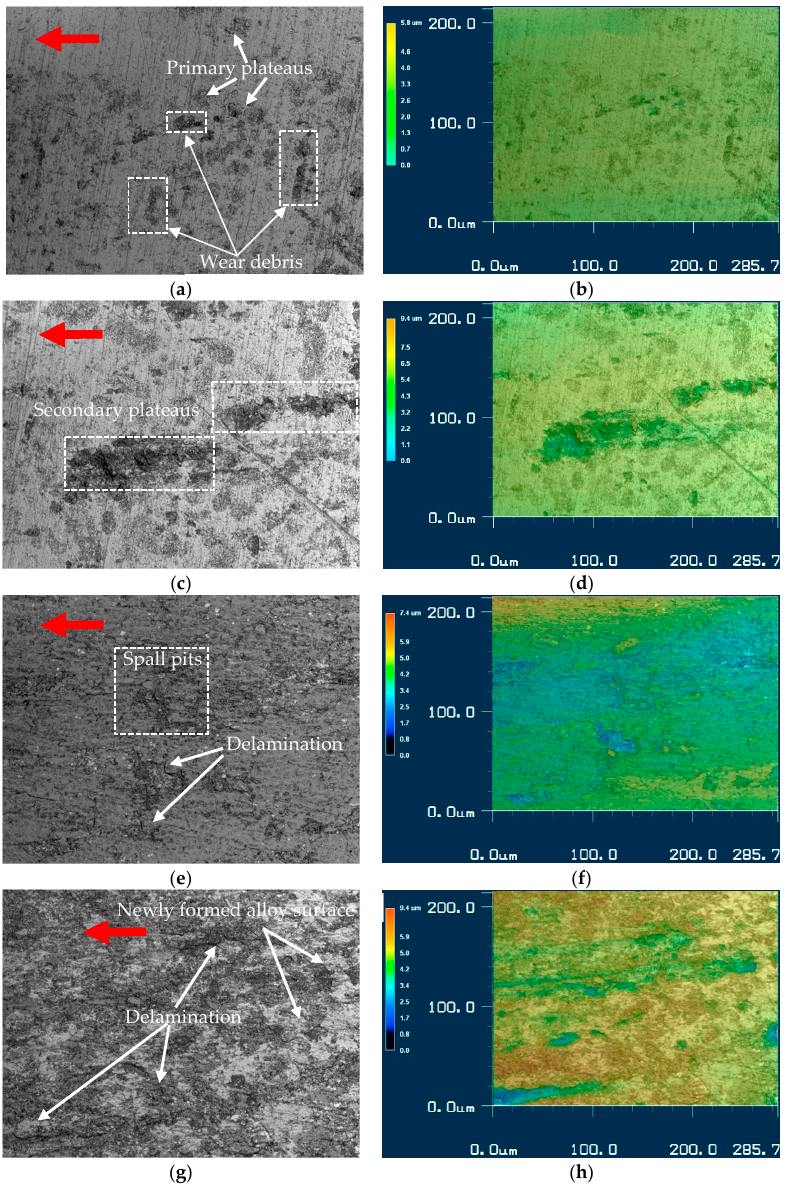
Figure 10. The friction surface topography ( a , c , e , g ) and 3D maps ( b , d , f , h ) of samples’ wear scars. ( a , b ): 4 MPa, Rz = 1.96 μ m, Ra = 0.22 μ m; ( c , d ): 7 MPa, Rz = 2.89 μ m, Ra = 0.29 μ m; ( e , f ): 10 MPa, Rz = 3.57 μ m, Ra = 0.37 μ m; and ( g , h ): 15 MPa, Rz = 6.1 μ m, Ra = 0.56 μ m.